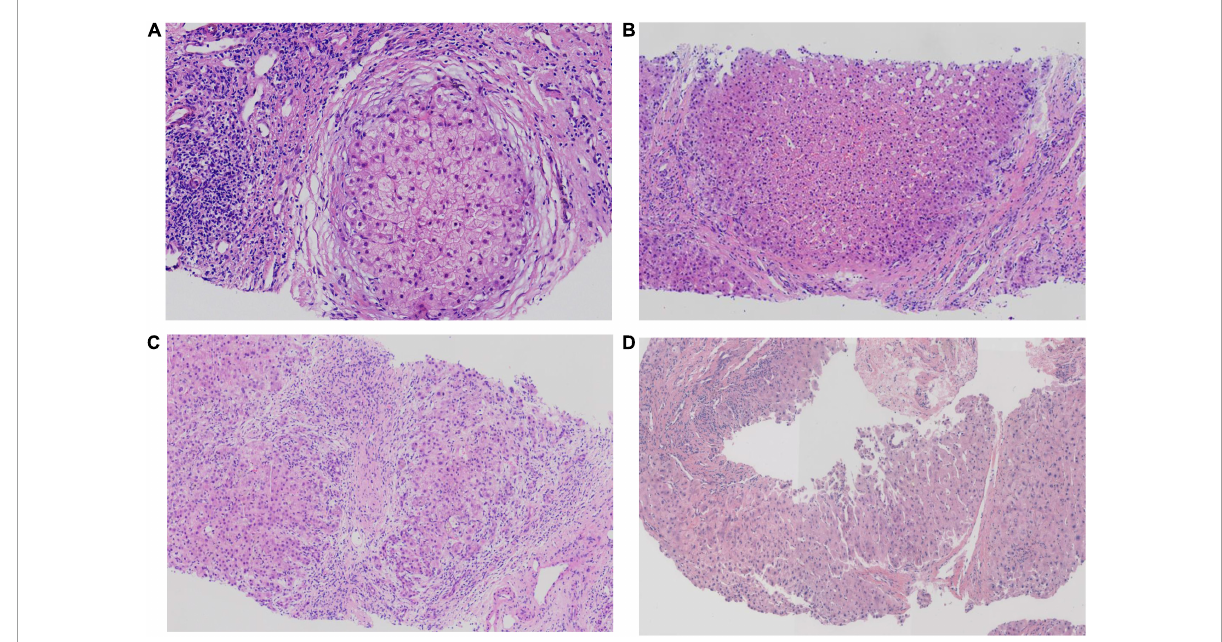
FIGURE1 Pathologic Features of Patients with PFIC3 in liver biopsy specimens. All patients with severe liver fibrosis and even cirrhosis (A–D) . Panel (A) shows a cirrhosis nodule and an air halo in the plasma of the hepatocytes around the nodules in patient 1. Panel (B) shows an incomplete cirrhosis nodule and the expansion of the hepatic sinuses in patient 2. Panel (C) shows severe liver fibrosis and mild inflammatory infiltration accompanied by ductular proliferation in patient 3. Panel (D) shows liver cirrhosis in patient 4. Panels (A–D) show H&E-stained samples; magnification: 200 × in (A–C) and 100 × in (D)